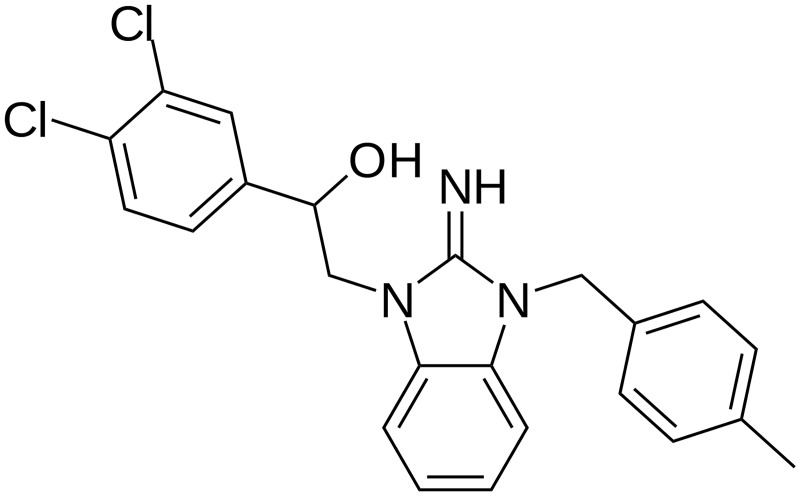
Yan 7874 structure.